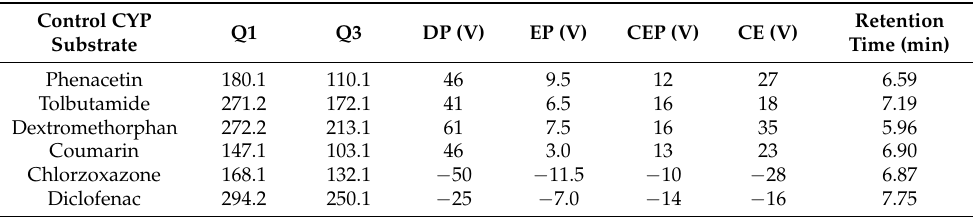
Table 1. Compound- and source-dependent parameters for control CYP substrate analytical method development a